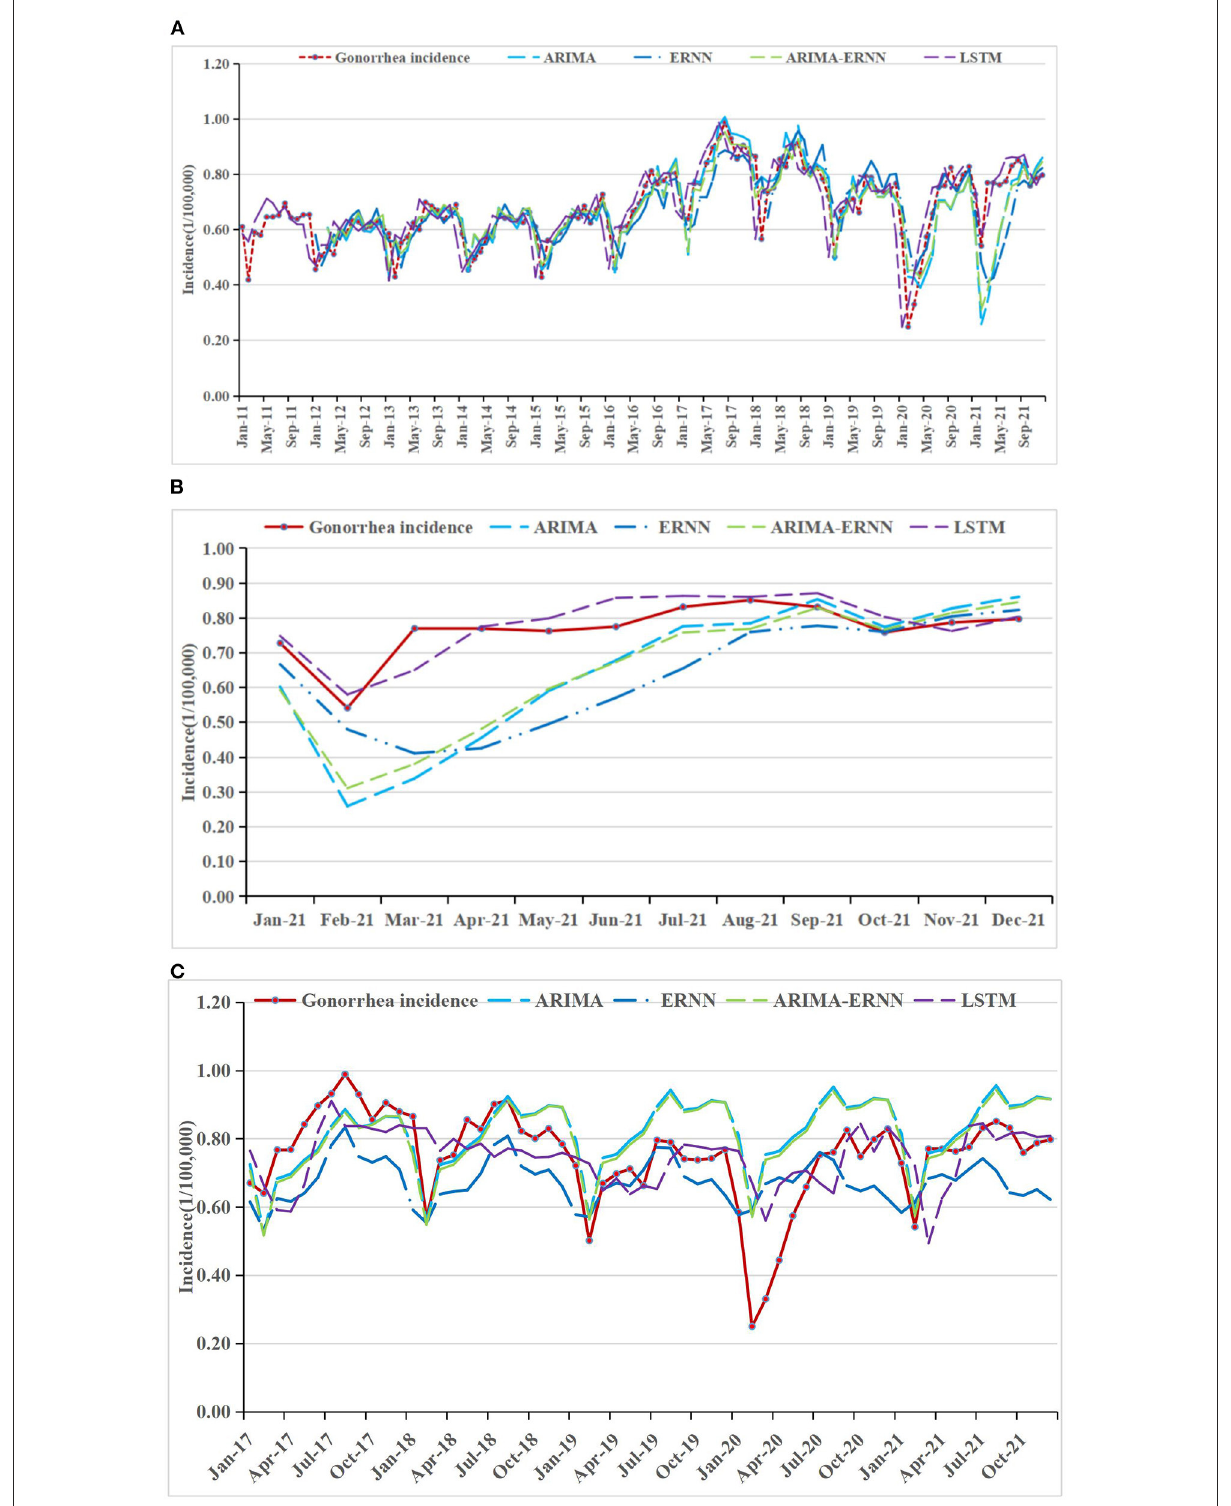
FIGURE3 Gonorrhea incidence and fitting values predicted by the four methods (A) in 2011–2021, (B) in 2021, and (C) in